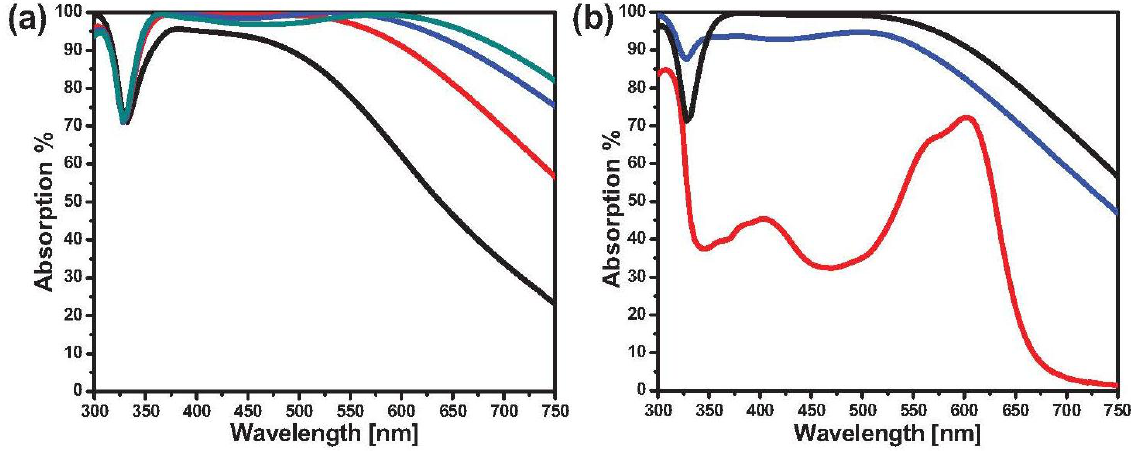
Figure 7. ( a ) Absorption spectra of silver-SiO 20 nm (red curve), 25 nm (blue curve), and 30 nm (green curve) thickness deposited on 15 nm SiO coated silver mirror; ( b ) Absorption spectra 200 nm silver film coated with 40 nm 2 polystyrene-SPO composite (red curve) and 20 nm silver-SiO filling factor deposited on 10 nm (blue curve) and 15 nm (black curve) SiO organic film is UV illuminated prior to measurement. (Reprinted with permission from [46].